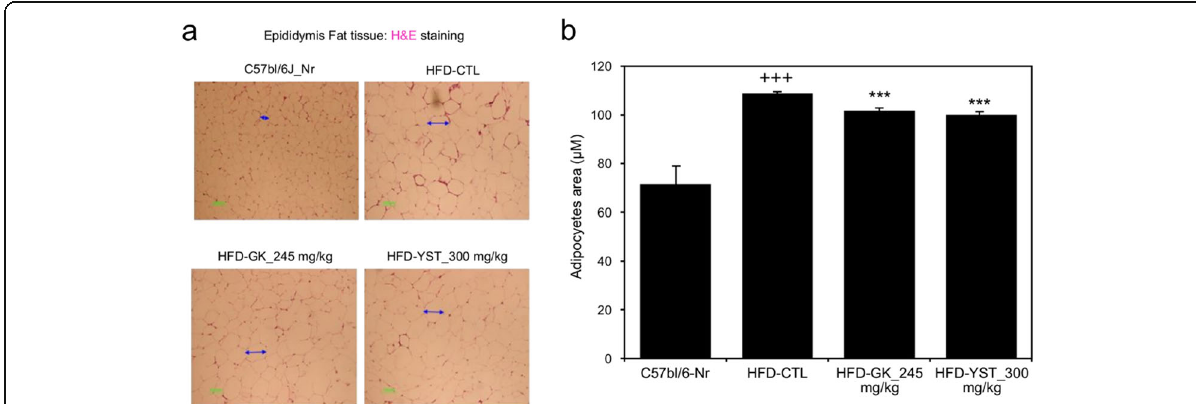
Fig. 6 Effects of YST on the histological profile, including ( a ) epididymal adipose tissue morphology and ( b ) adipocyte area, of epididymal adipose tissue in mice that were fed a high-fat diet (HFD). Normal diet group: C57bl/6 J-Nr; HFD-control group: HFD-CTL; HFD plus 245 mg/kg Garcinia cambogia extract: HFD-GK; HFD plus 300 mg/kg YST: HFD-YST. The results are expressed as mean ± SEM ( n = 6). + p < 0.05, ++ p < 0.01, and +++ p < 0.001 compared with C57bl/6 J-Nr, and * p < 0.05, ** p < 0.01, and *** p < 0.001 compared with